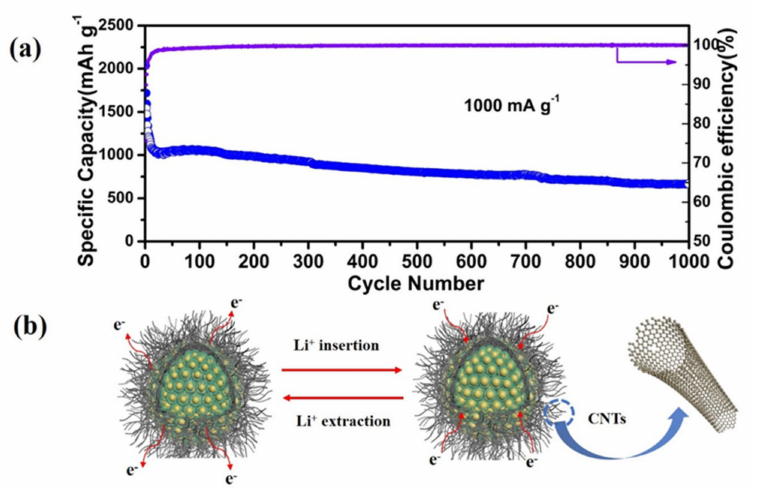
Figure 5. Cycle performance of Si@C@v@CNTs at a current density of 1000 mA g − 1 ( a ) and a schematic illustration of lithiation and delithiation processes ( b